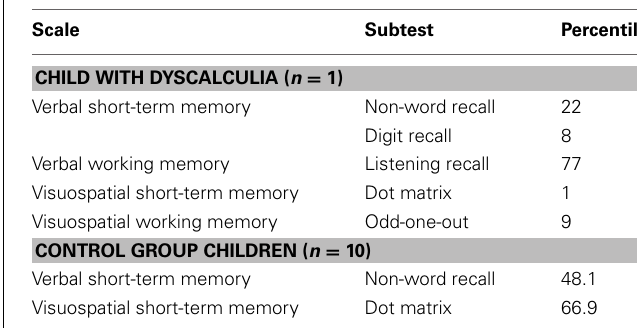
Table 1 | Working memory scores of the child with dyscalculia and the control